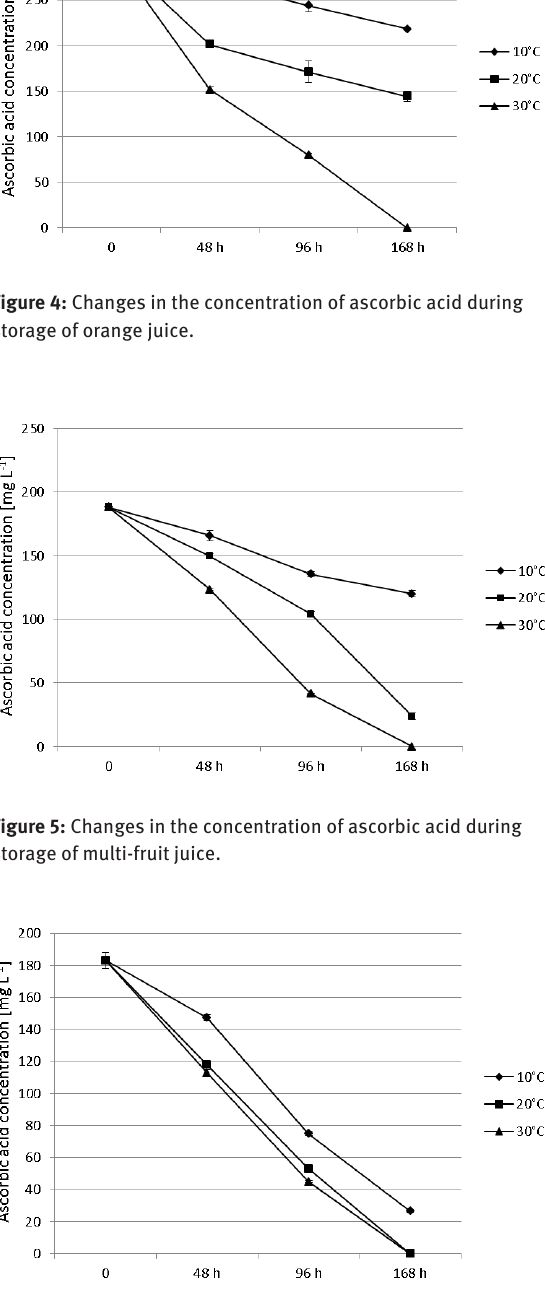
Figure 6: Changes in the concentration of ascorbic acid during storage of blackcurrant